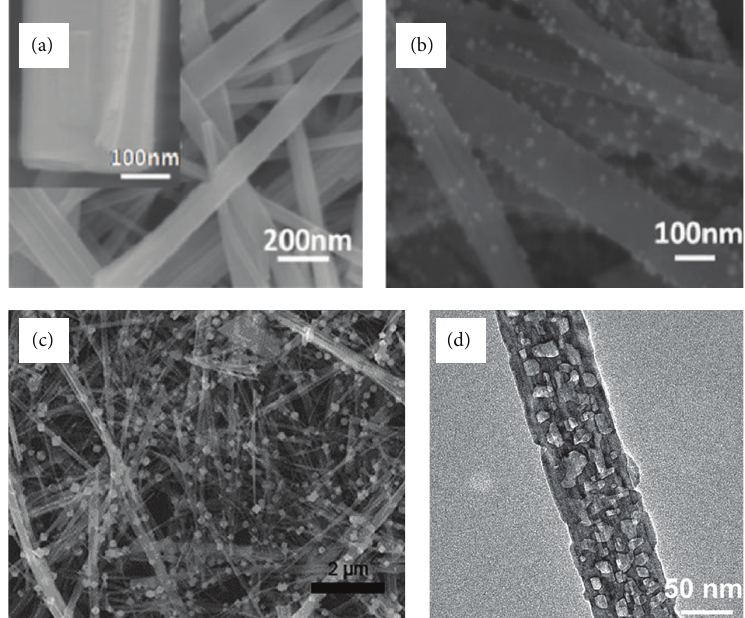
Figure 10: (a) SEM image of TiO 2 nanobelts synthesized via a hydrothermal process [70], (b) SEM image of NiO/TiO 2 heterojunctions [64], (c) SEM image of the Cu 2 O/TiO 2 heterojunctions [71], and (d) TEM image of the synthesized CeO 2 /TiO 2 nanobelt heterojunction